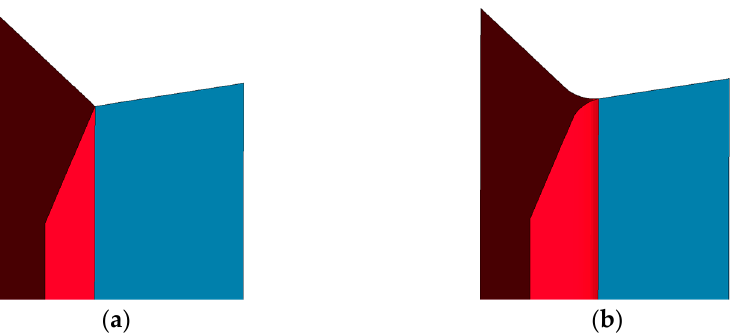
Figure 7. Geometric models of the core for the following versions: ( a ) simple/idealized; ( b ) showing the mapped shape of the rounded walls.